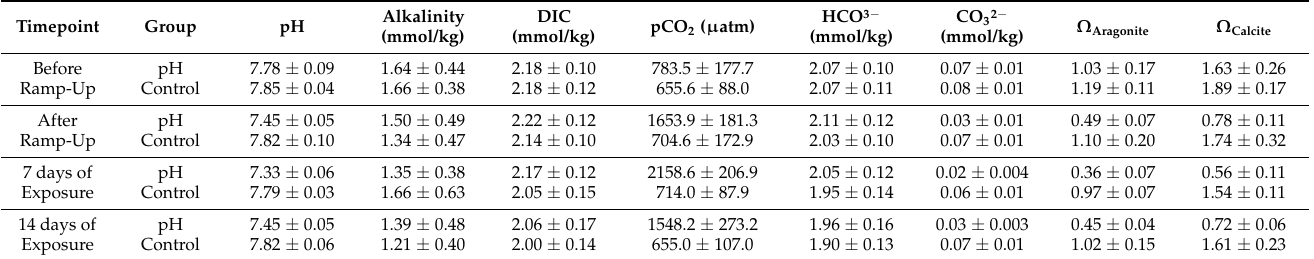
Table 3. The mean ± standard deviation of water carbonate chemistry parameters measured (pH, alkalinity, dissolved inorganic carbon (DIC)) and calculated (all others) for pH group and control group tanks before ramp-up, after ramp-up, after 7 days of exposure and after 14 days of